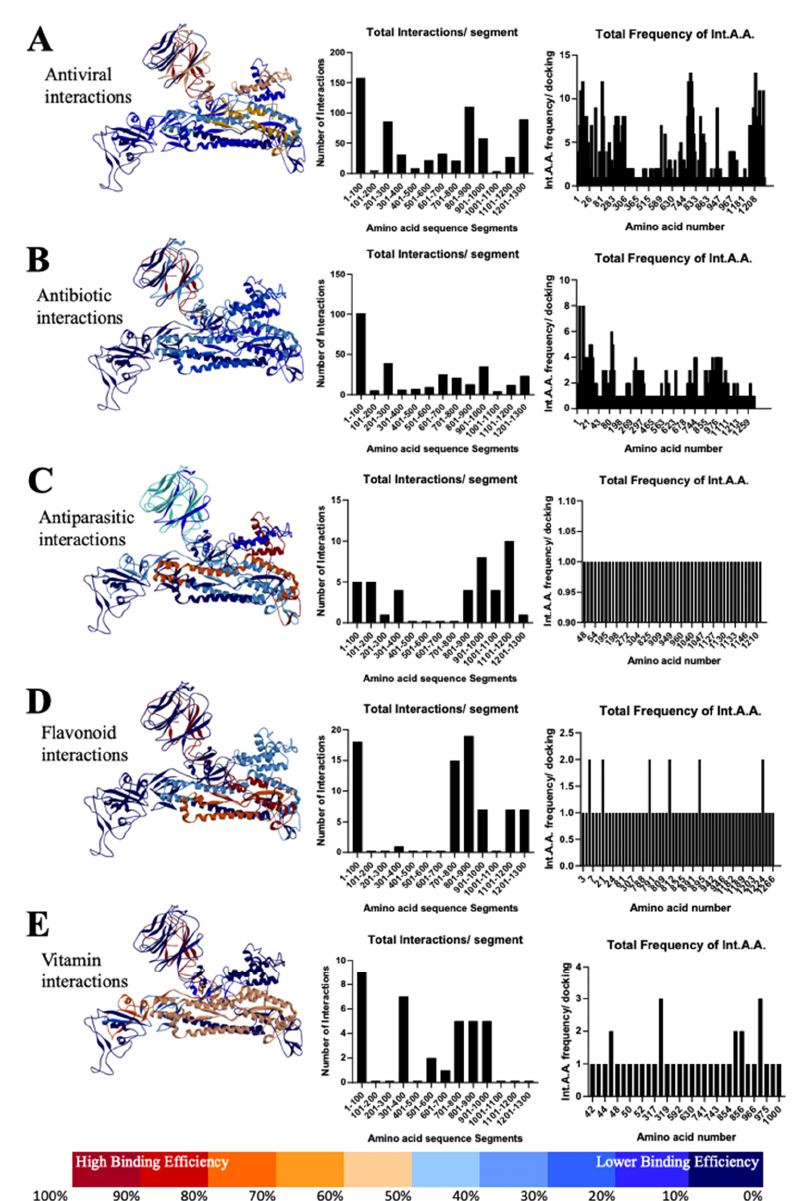
Figure 5. Heat map of the Spike protein represents the frequency of antiviral drug bindings against the 12 segments of the protein. Simulations suggest a preference of antiviral drugs to bind around the S1-NTD region and S2 ( A ); similar results were observed in flavonoid interactions ( D ). Docking of antibiotic drugs exhibits a preference in the S1-NTD region only ( B ). Antiparasitic drugs interestingly showed a higher binding fre- quency in S2 of the protein ( C ). From the perspective of the vitamins, they were shown to bind in both the S1-NTD/–CTD region and S2 ( E ).